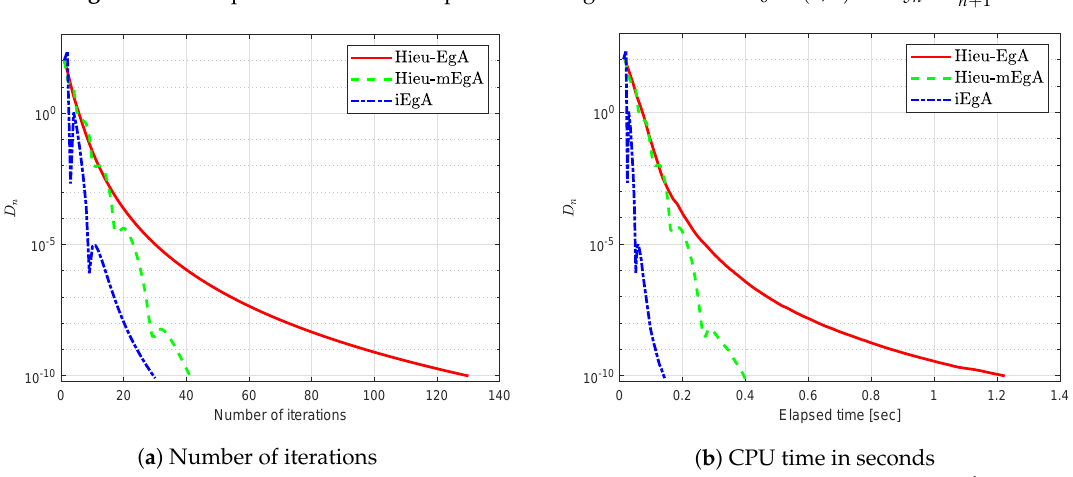
Figure 12. Example 4: Numerical comparison for Algorithm 1 while u 0 = ( 1,1 ) and ζ n = 1